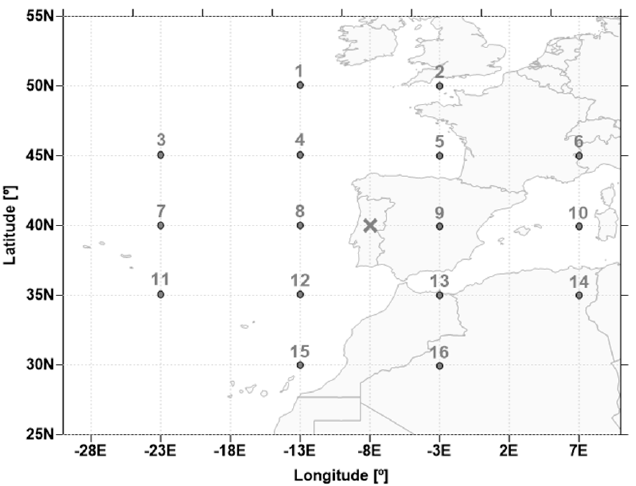
Figure 2. Sea level surface pressure points and central latitude point “x” used to identify and clas- sify the weather circulation